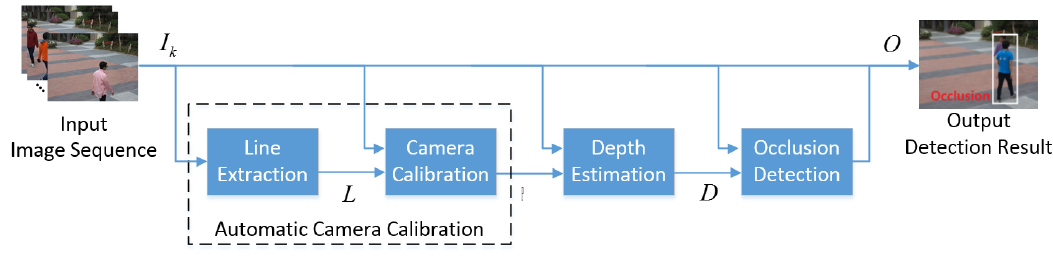
Figure 2. Block diagram of the proposed occlusion detection